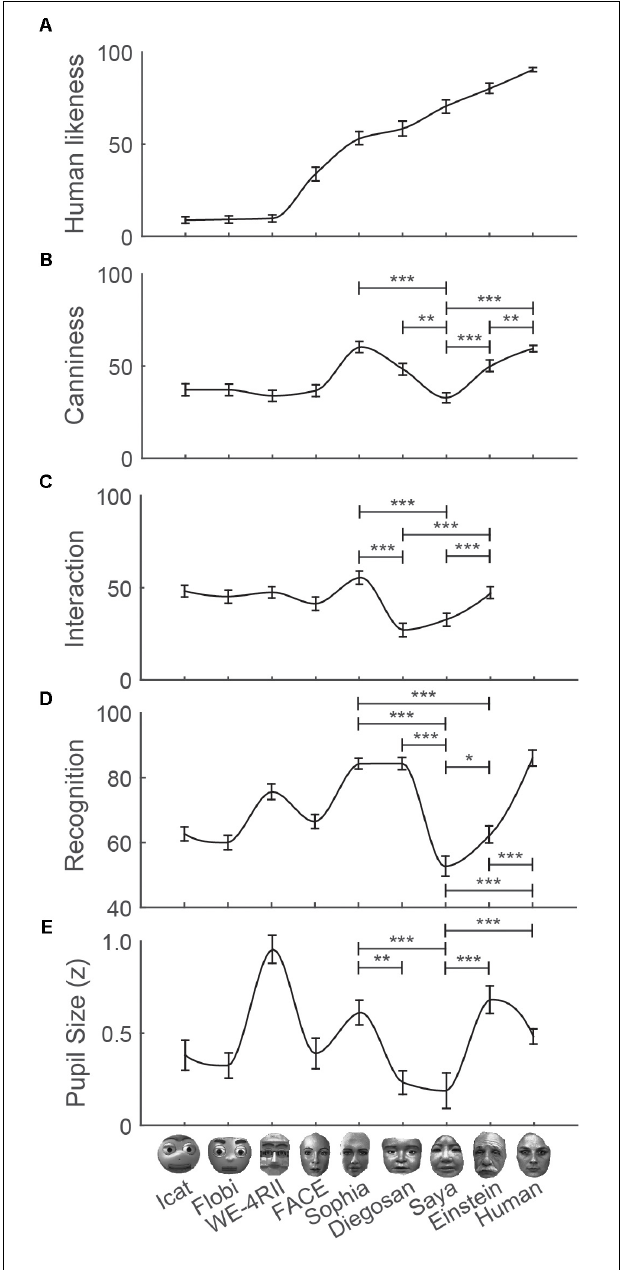
FIGURE 2 | The uncanny valley confirmed: average scores with standard errors on a variety of measures. (A) Human likeness across participants, (B) uncanniness, (C) comfortability with robotic applications, (D) emotion recognition performance, and (E) average pupil size between 1 and 3 s after stimulus onset per robot character. The robot characters are ordered by scores on human likeness and the last character (outmost right) shows the average score pooled across all human characters. The most relevant statistical comparisons between robots are indicated with asterisks ( ∗ p < 0.05, ∗∗ p < 0.01, ∗∗∗ p <